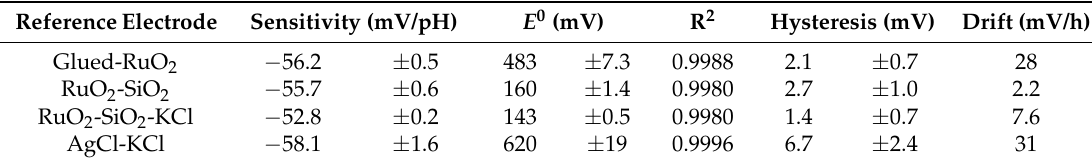
Table 3. Summary of pH sensor performance calculated from pH loop data .